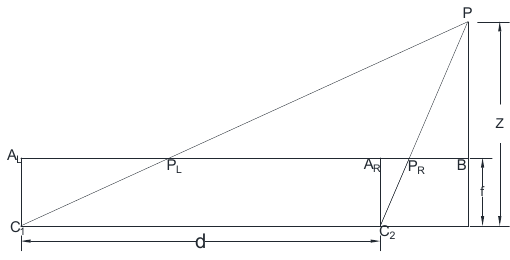
Figure 6. Schematic of binocular stereo vision.